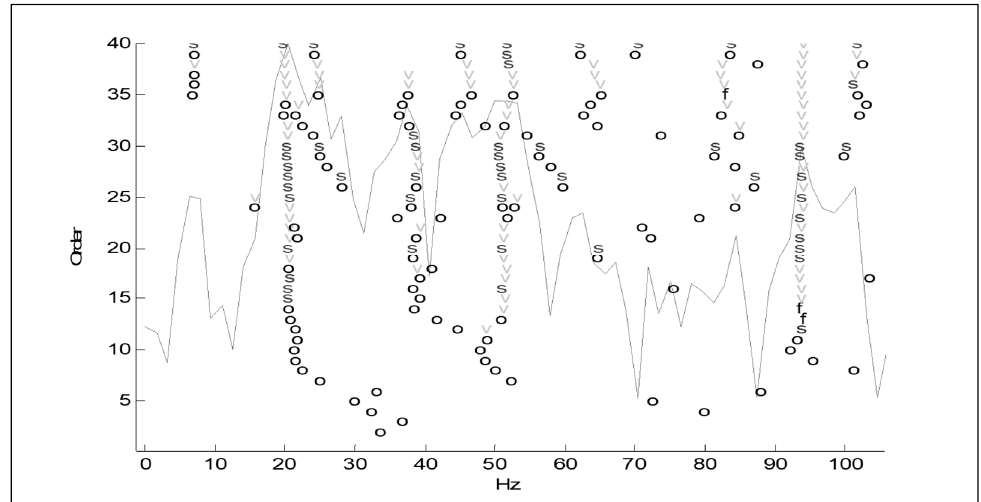
Figure 5. Stabilization diagrams. Notations: order—order of the pole, o—unstable pole, f—pole has a constant frequency. The v-pole has a constant frequency and modal vector; s—stable pole.